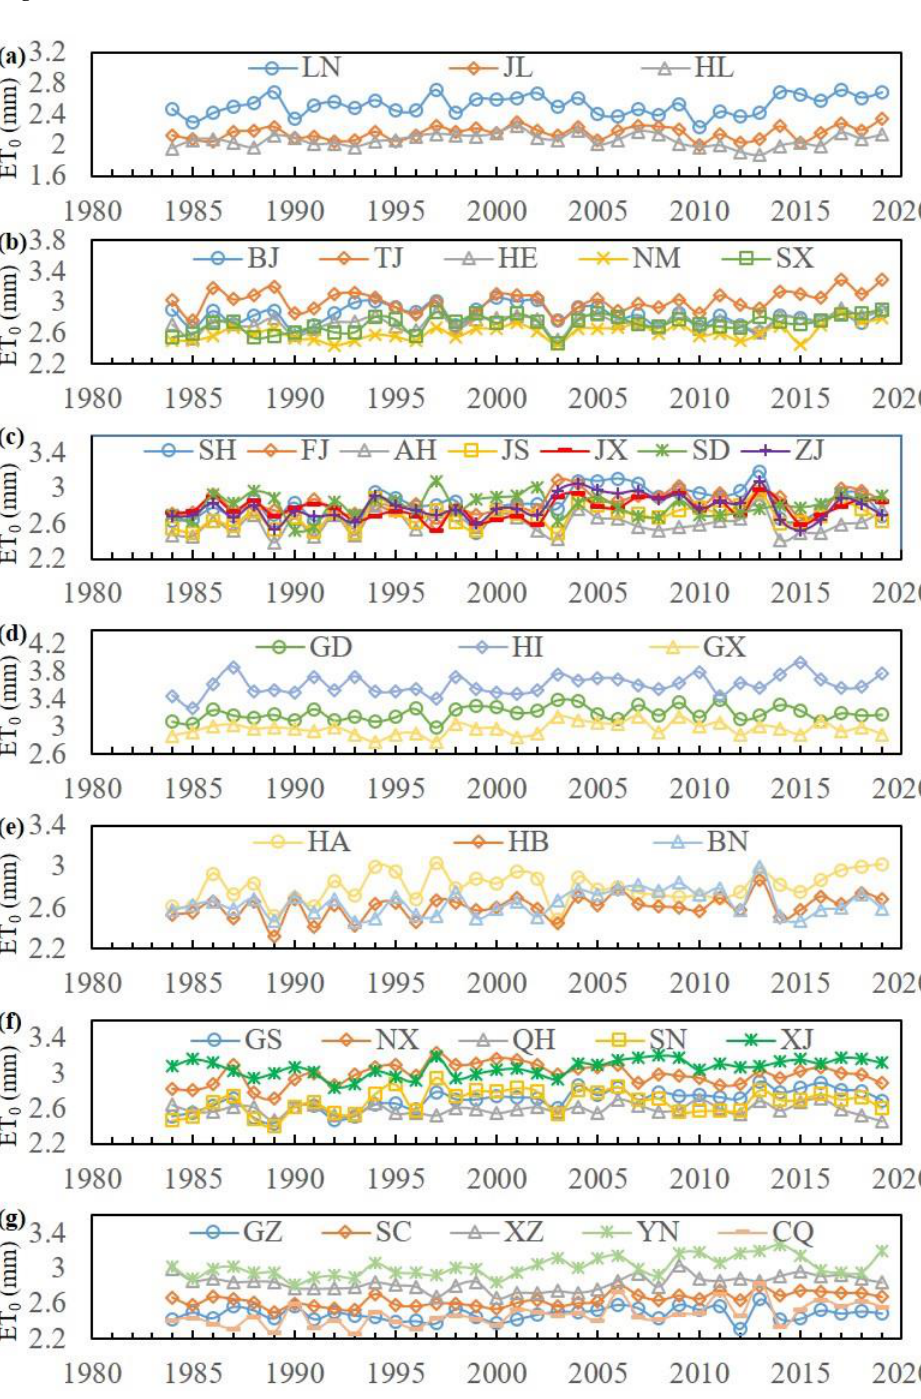
Figure 6. Annual mean daily ET 0 in different regions: ( a ) NER; ( b ) NCR; ( c ) ECR; ( d ) SCR; ( e ) CCR; ( f ) NWR; ( g ) SWR.